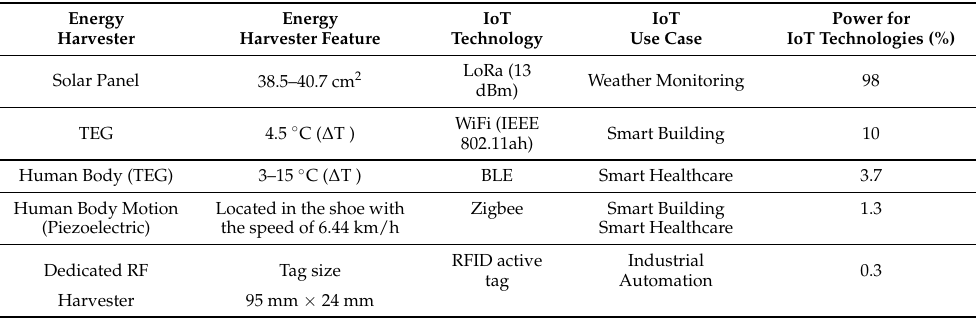
Table 6. Experimental analyses in literature on the suitability of specific energy harvesters with IoT technologies